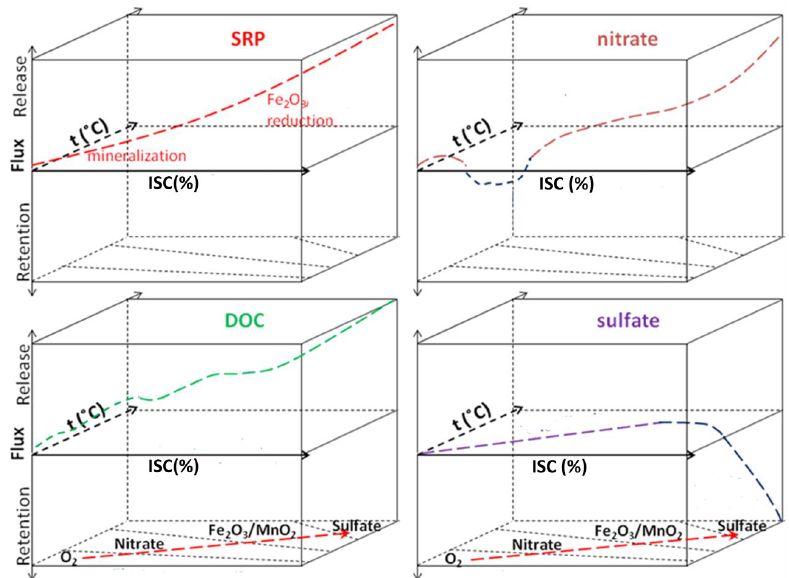
Fig. 8. Conceptual model of how temperature ( t ) and land use interactively impact C, N, S, P fluxes in stream sediments. Land use effect is indicated by percent impervious surface cover (ISC%). The area at the bottom of each box shows that oxygen (O 2 ), nitrate, Fe 2 O 3 /MnO 2 and sulfate sequentially act as the primary electron acceptors as sedimentary organic matter decomposition intensifies with warming or ISC. Given that stream sediments are heterogeneous with respect to redox conditions, these reactions may occur simultaneously in streams in nature. Different colors are used to represent positive (release) and negative (retention) values for sediment